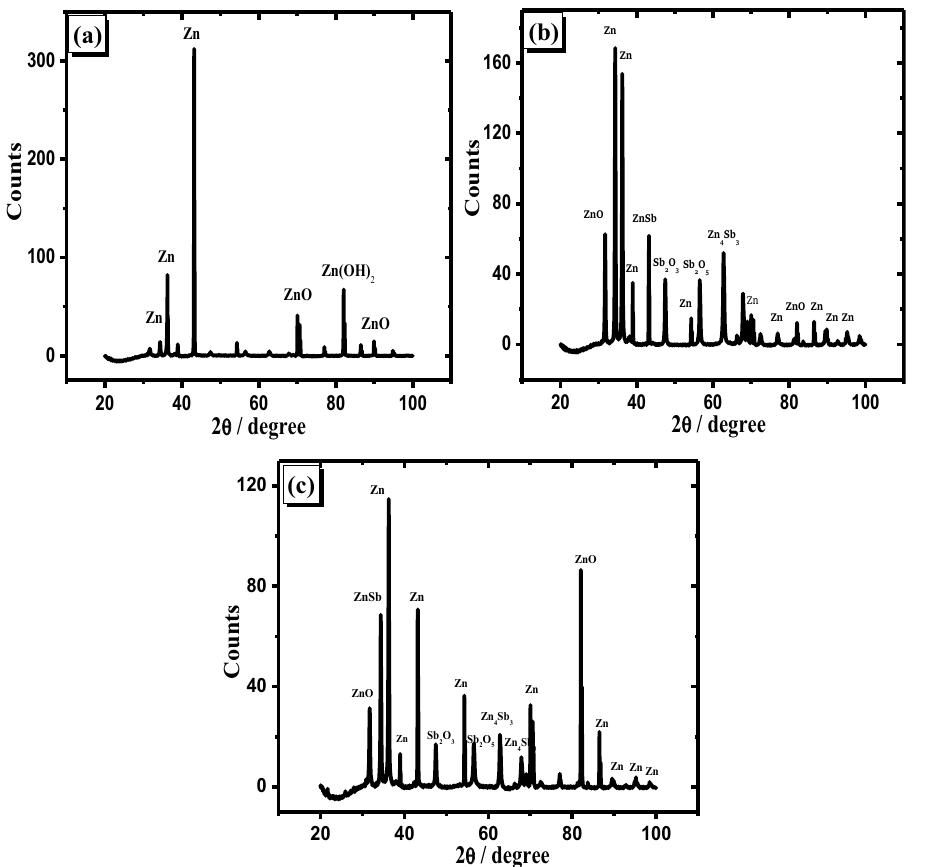
Figure 8. Patterns of XRD for the anodically generated oxide film at + 0.8 V on the pristine zinc ( a ) and its alloys; I ( b ) and II ( c ) in 6 M KOH at 25 °C.